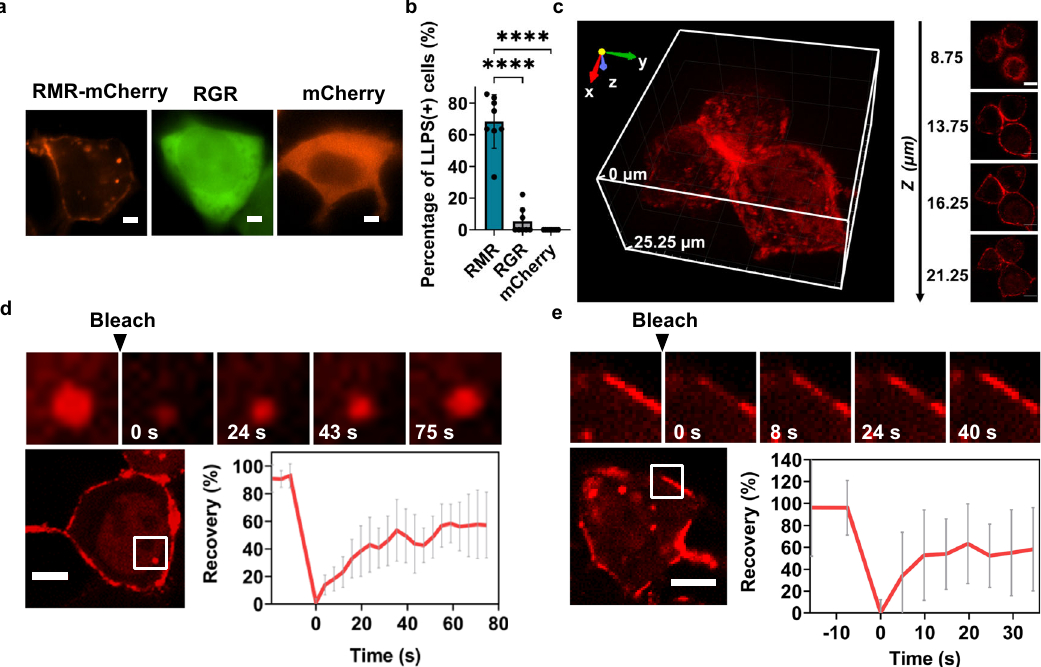
Fig. 8 Phase separation in living cells. a Fluorescent images of HEK293 cells transfected with the gene encoding RGG-Mfp-3-RGG-mCherry (RMR- mCherry), mCherry, or RGG-GFP-RGG (RGR). Scale bars: 5 μ m. b Percentage of HEK293 cells that exhibit LLPS. Data are presented as mean ± SD ( n = 8); two-side t -test, p -value: **** < 0.0001, p = 9.30 × 10 − 6 (RMR vs RGR); p = 8.89 × 10 − 6 (RMR vs mCherry). c 3D rendering and representative z -slice images of HEK293 cells producing RMR-mCherry. Scale bars: 10 μ m. FRAP assays of RMR condensates in the cytoplasm ( d ) and in the outer membrane of HEK293 cells ( e ). The plots show the normalized fl uorescence recovery after photobleaching. Scale bars: 10 μ m. Data are presented as mean ± SD ( n = 8 in d and n = 16 in e